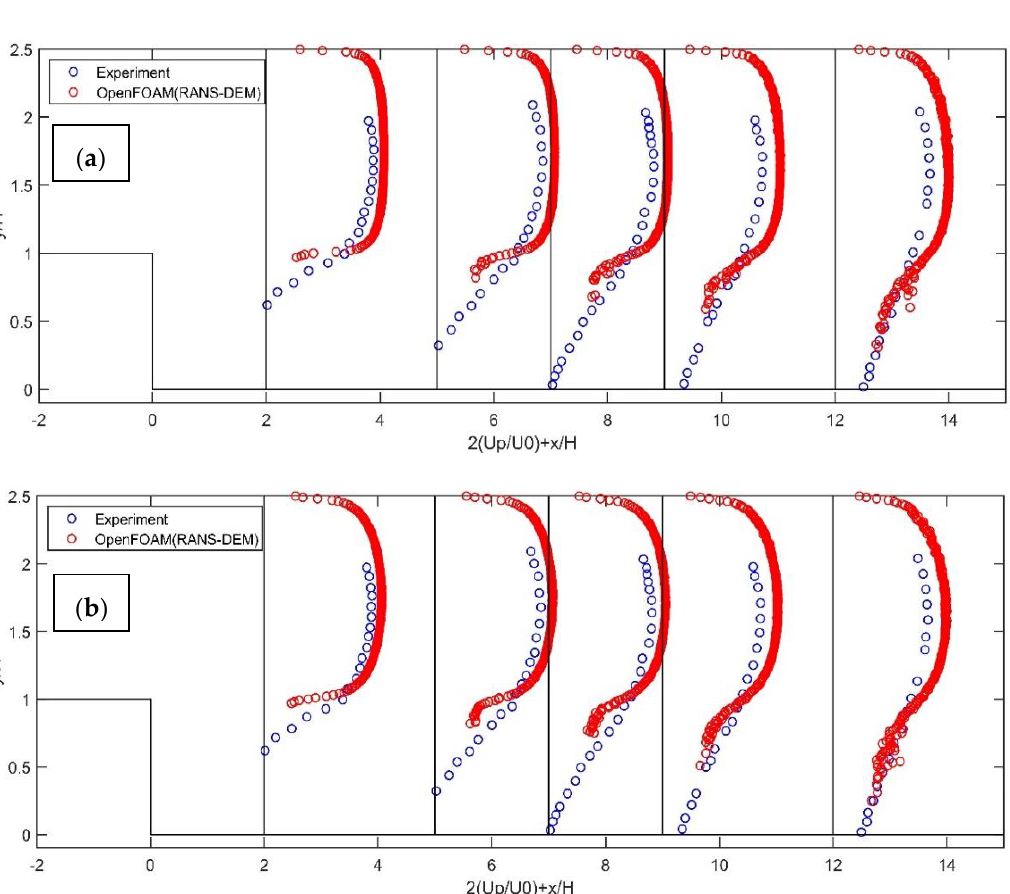
Figure 7. Comparisons of experimental and OpenFOAM simulated average streamwise particle ve- locity profiles at the measurement locations for one-way coupling and 10% mass loading of copper particles under RANS-DEM framework. ( a ) Particle injection velocity as (10.5, 0, 0) m/s, ( b ) particle injection velocity same as that of the fluid velocity profile at inlet, ( c ) particle injection velocity as (0, 0, 0) m/s.